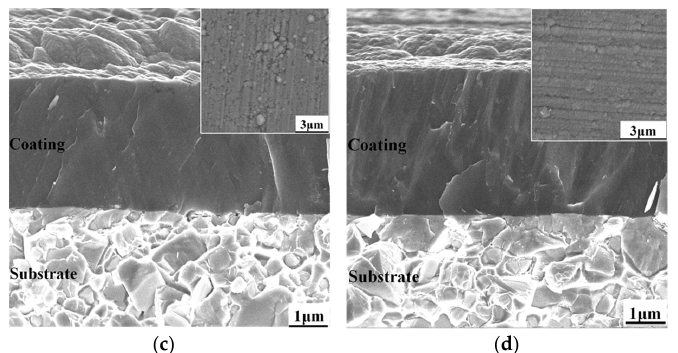
Figure 5. The surface (insets) and cross ‐ sectional scanning electron microscopy (SEM) micrographs of AlCrN coatings deposited at different charge voltages: ( a ) 350 V; ( b ) 450 V; ( c ) 500 V; ( d ) 550 V.